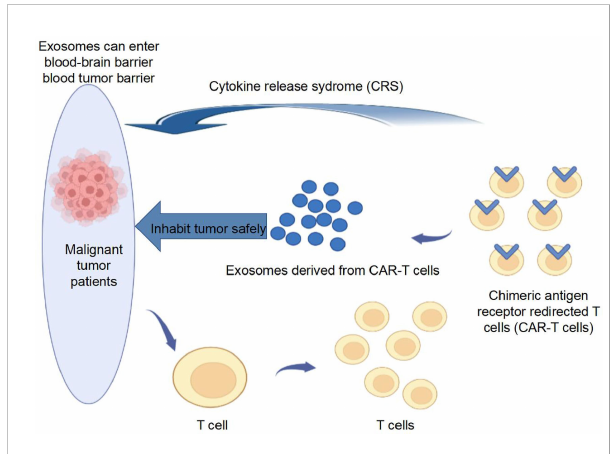
FIGURE 2 CAR-T cell-derived exosomes for tumor treatment. CAR-T cell- derived exosomes express high levels of cytotoxic molecule, making them effective vectors to provide pro-apoptotic cues to target tumor cells carrying homologous